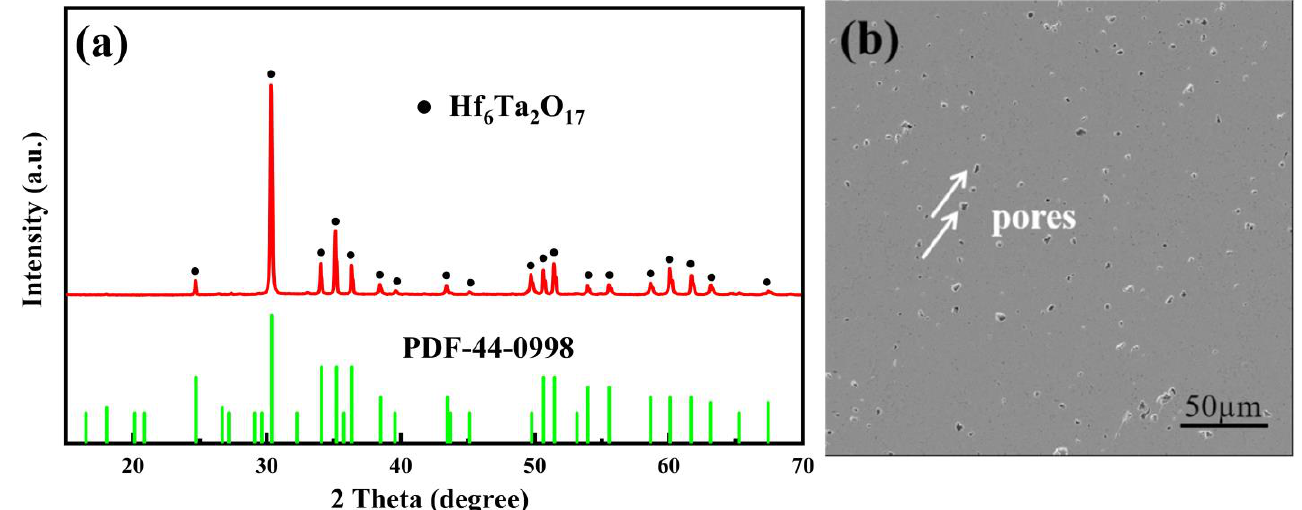
Figure 2. ( a ) XRD patterns of as-sintered Hf 6 Ta 2 O 17 ceramic; ( b ) surface morphology of Hf 6 Ta 2 O 17 ceramic.